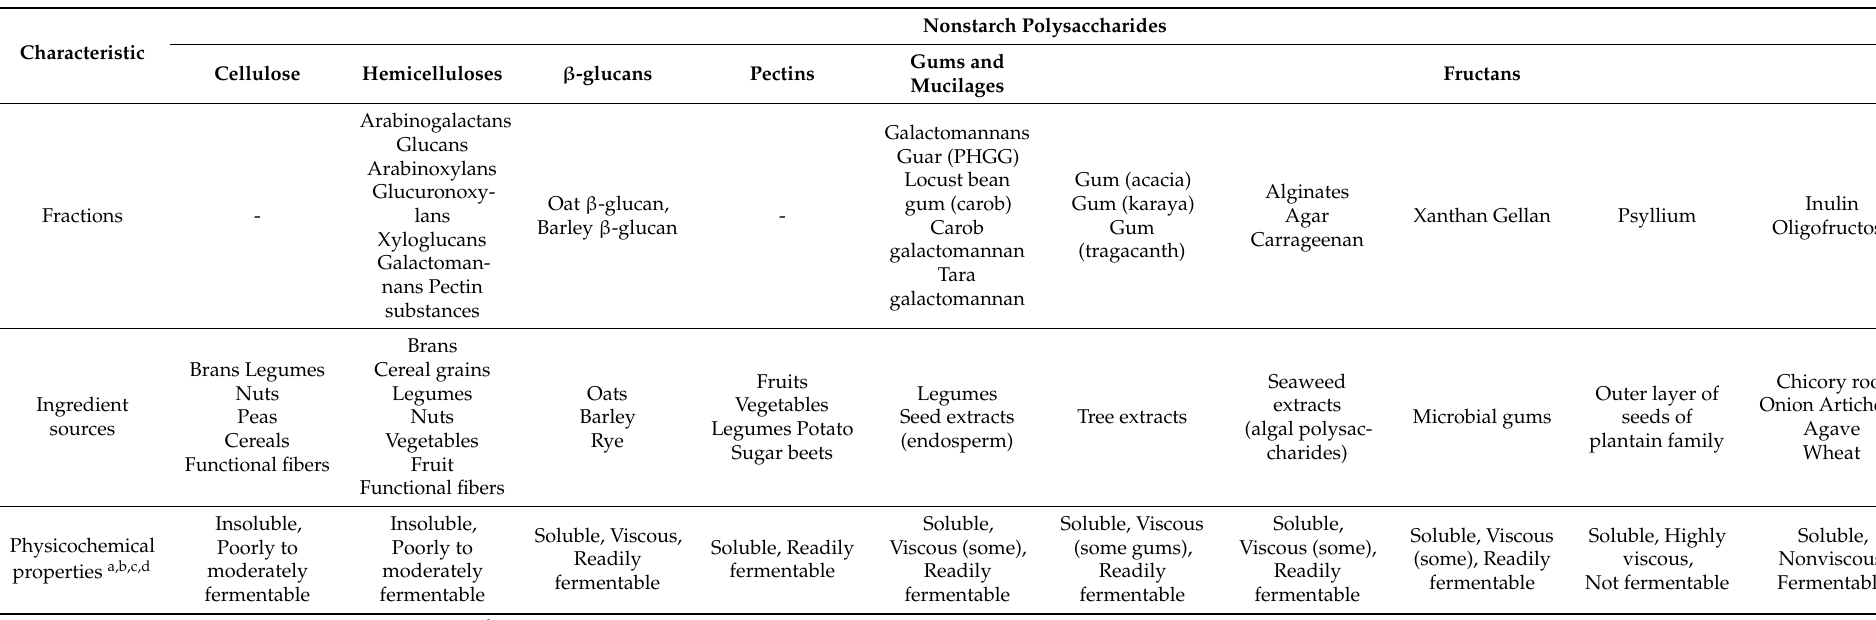
Table 3. Summary of carbohydrate fractions, ingredient sources, and physiological properties of nonstarch polysaccharides in foods and feed ingredients (adapted from